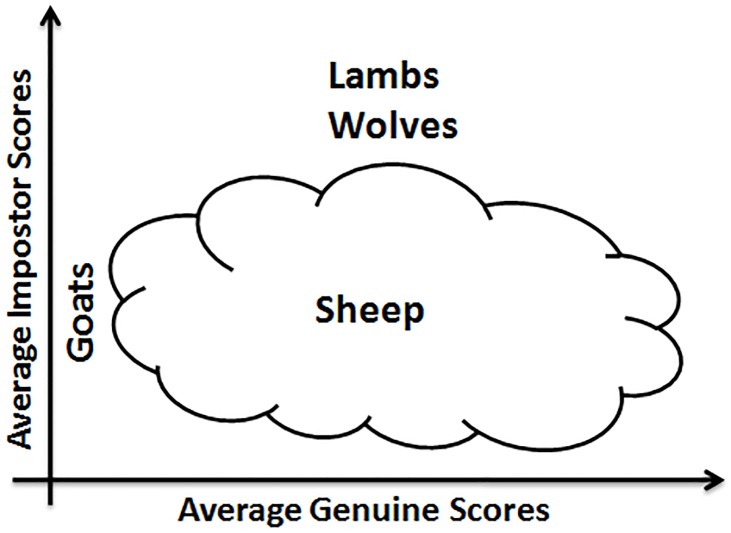
Doddington’s representation of the Biometric Menagerie [11].